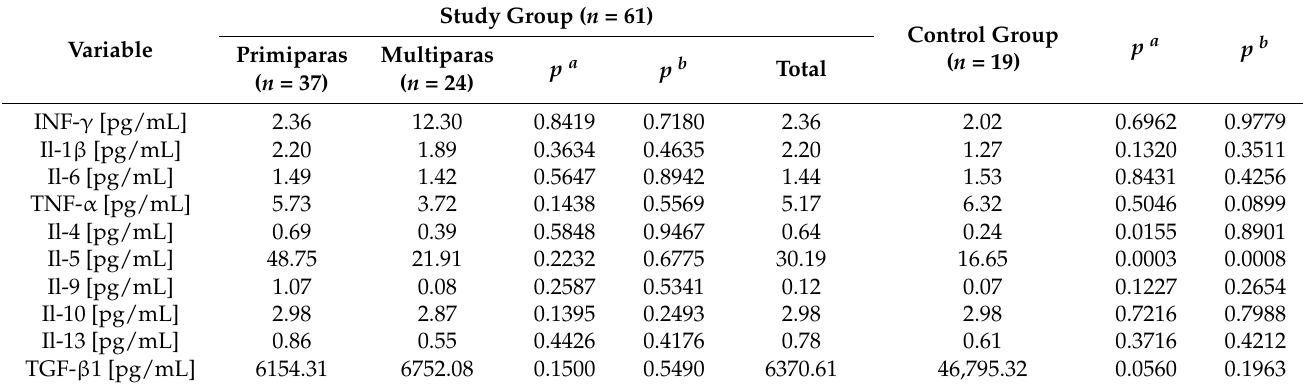
a —univariate analysis, b —analysis of covariance (age as covariate).